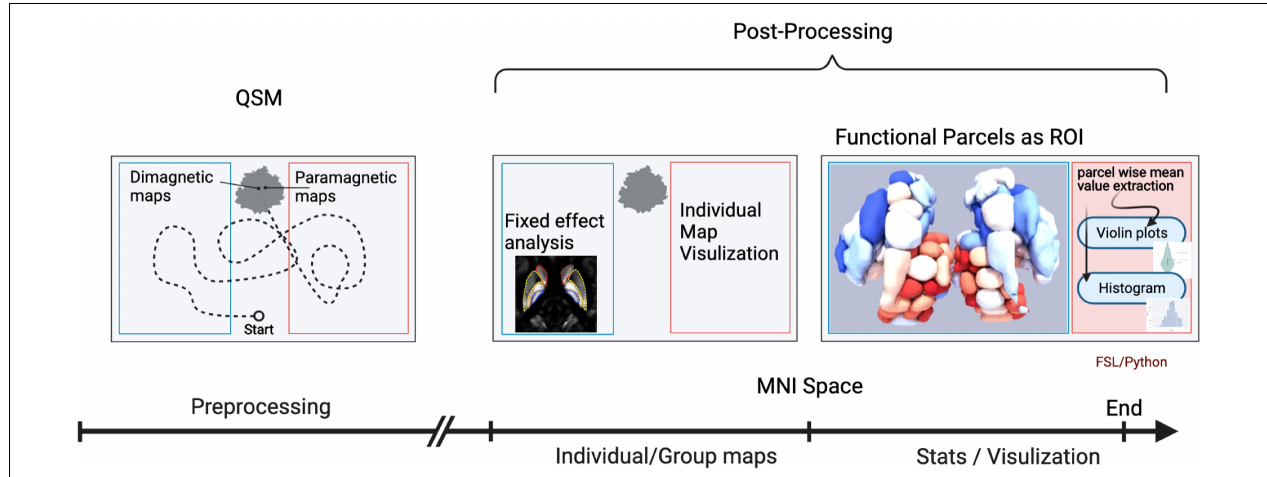
FIGURE 1 | Workflow of the quantitative susceptibility mapping (QSM) evaluation. An illustration of the workflow depicts the analysis steps. The first analysis step was a mix of several preprocessing steps: (1) generation of QSM maps by using background removal imposing image smoothness and moderate contrast; (2) transformation into standard MNI brain space, after co-registration to anatomy data of each individual subject with known spatial transformation (DARTEL), and reslicing onto a grid with isotropic 400 µ m voxels using trilinear interpolation; (3) bifurcation/subdivision into diamagnetic and paramagnetic components. In the next step, the diamagnetic and paramagnetic maps were bifurcated from the normalized QSM maps. Afterward, in the post-processing steps, individual as well as group fixed maps were visualized. The last analysis step encompasses statistics and visualization of the group results. The graphical workflow was created with BioRender.com https://app.biorender.com/biorender-templates.